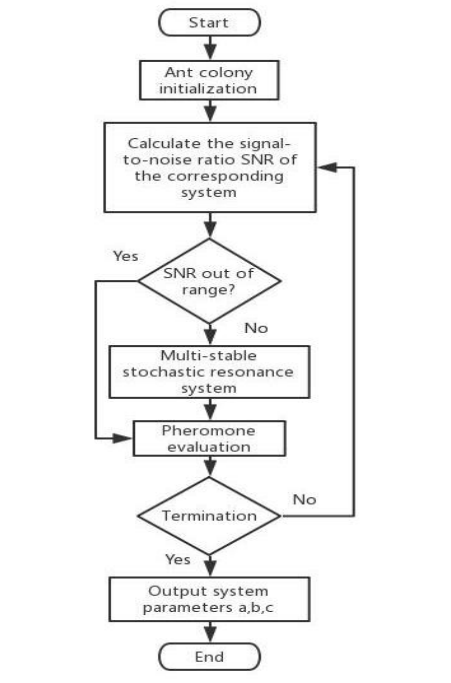
Figure 9. Ant Colony-based adaptive multi-stationary stochastic resonance flow chart.